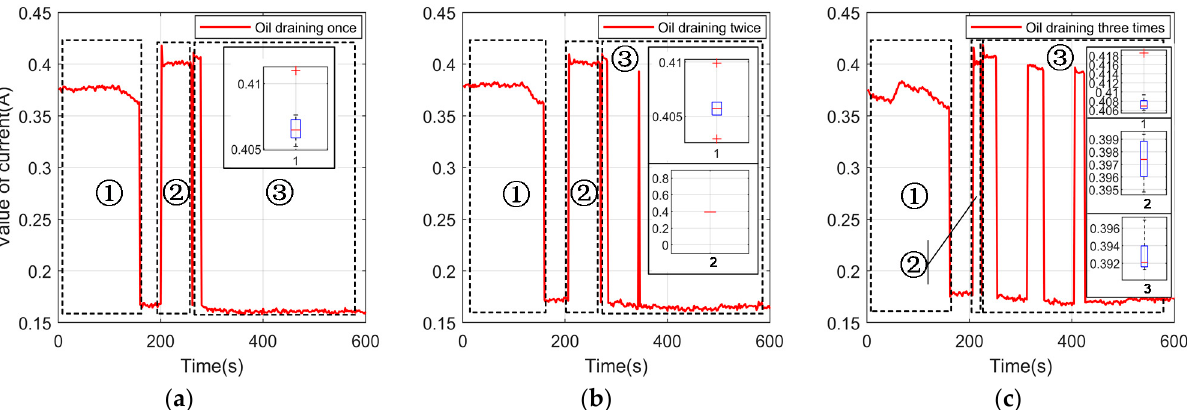
Figure 12. ( a ) Value of current when the oil is draining once; ( b ) Value of current when the oil is draining twice; ( c ) Value of current when the oil is draining three times